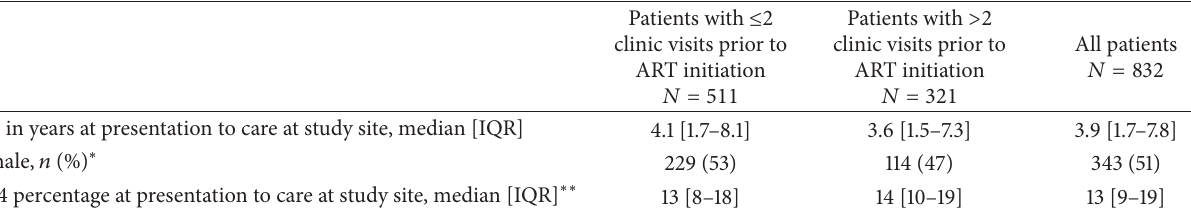
Patients with ≤ 2 Patients with > 2 clinic visits prior to clinic visits prior to All patients 𝑁 = 832 ART initiation ART initiation 𝑁 = 511 𝑁 = 321